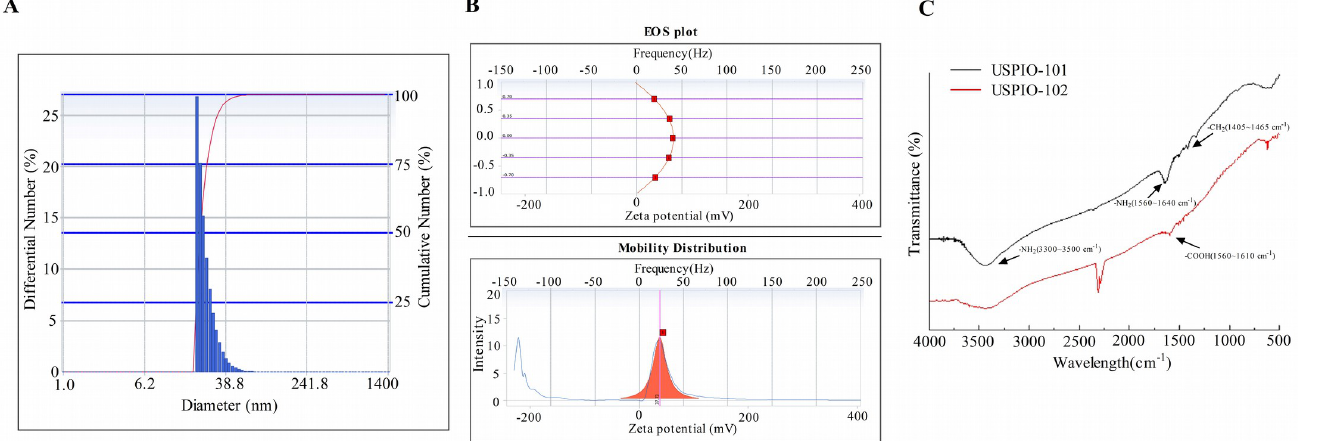
Figure 1. The dynamic light scattering (DLS), zeta potential analysis, and Fourier transform infrared spectroscopy (FTIR) spectra of ultrasmall magnetic iron oxide nanoparticles. ( A ) number distribution of USPIO-101, as measured by DLS. The concentration of USPIO-101 was 1 mg/mL. ( B ) Zeta potential analysis of USPIO-101. ( C ) Fourier transform infrared (FTIR) spectra are presented for USPIO-101 (black) and USPIO-102 (red), respectively. The -NH 2 and -CH 2 group signals are expressed in USPIO- 101 at the wavelength of 3300~3500 cm − 1 , 1560~1640 cm − 1 , or 1405~1465 cm − 1 (arrow). The -COOH group signal is expressed in USPIO-102 at the wavelength of 1550~1610 cm − 1